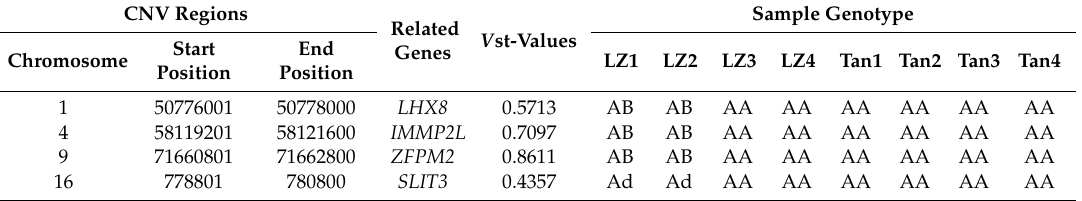
Table 1. The information of the four candidates copy number variation region and the genotype of eight